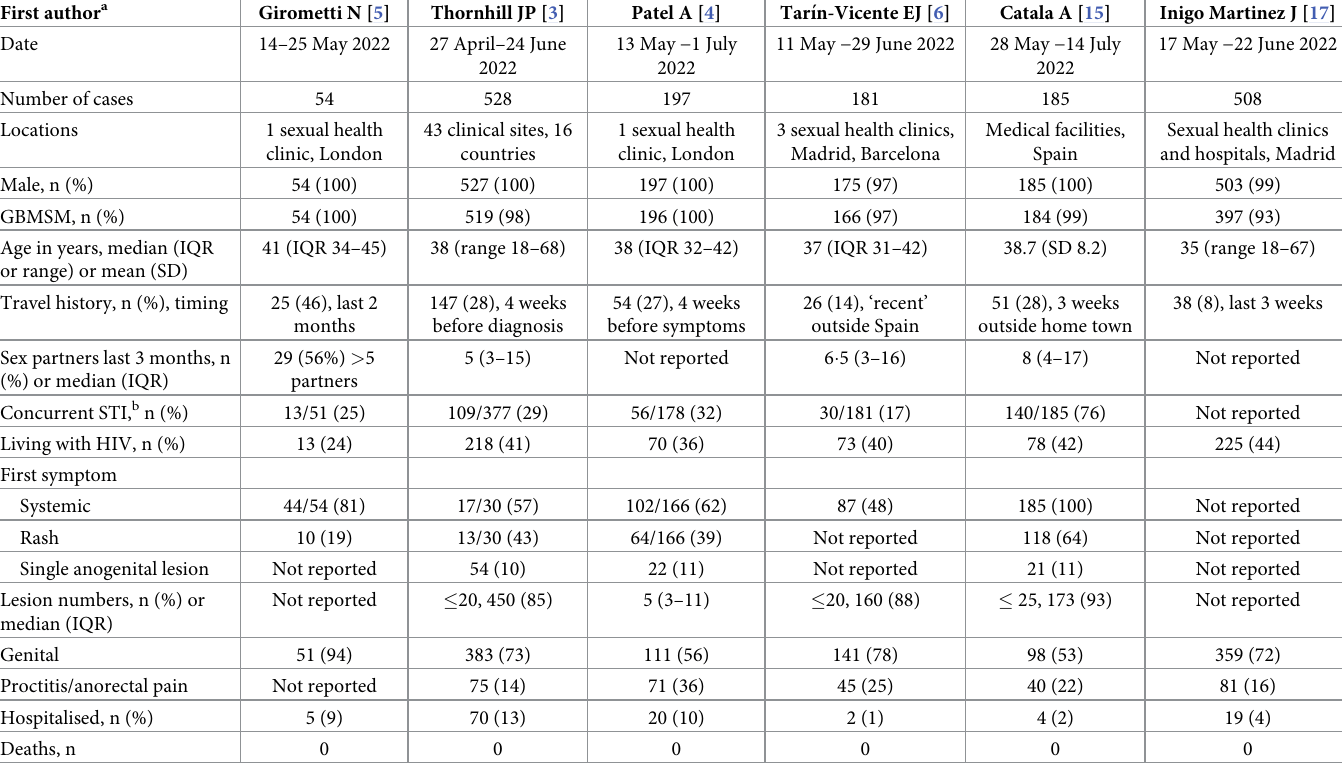
Table 1. Clinical and behavioural findings from mpox case series with more than 50 cases published in July 2022, by date of